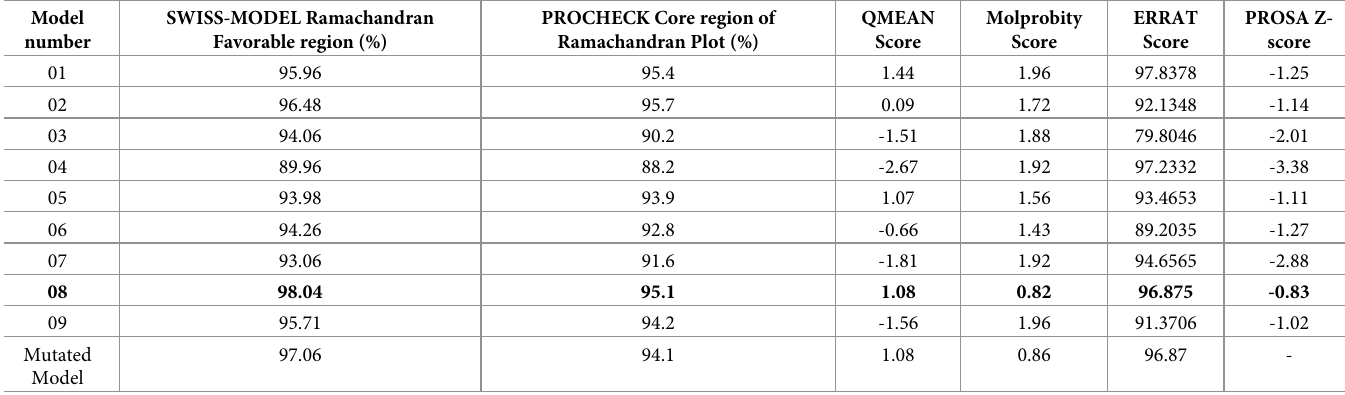
significant genes The muTarget links mutation with gene expression alteration and provides expression plots. We used it for two independent analysis. Firstly, the ‘Genotype’ run with MTUS1 as mutated gene Table 5. Scores of different structural assessment tools for the predicted models from SWISS-MODEL homology-modeling server. Model